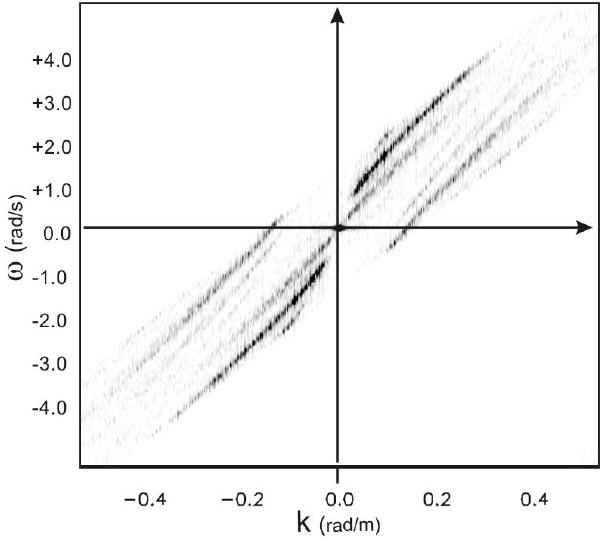
Figure 17. The assembled spectrum according to the procedure proposed